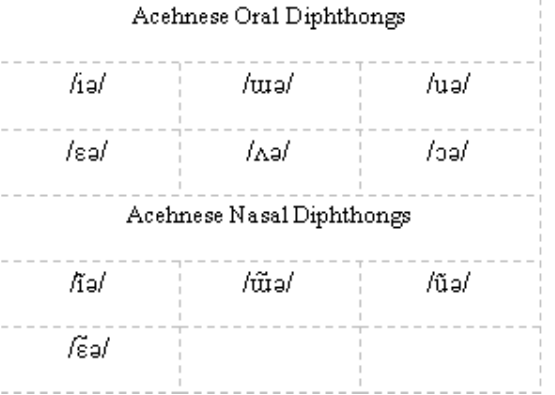
Figure 3. Acehnese oral and nasal